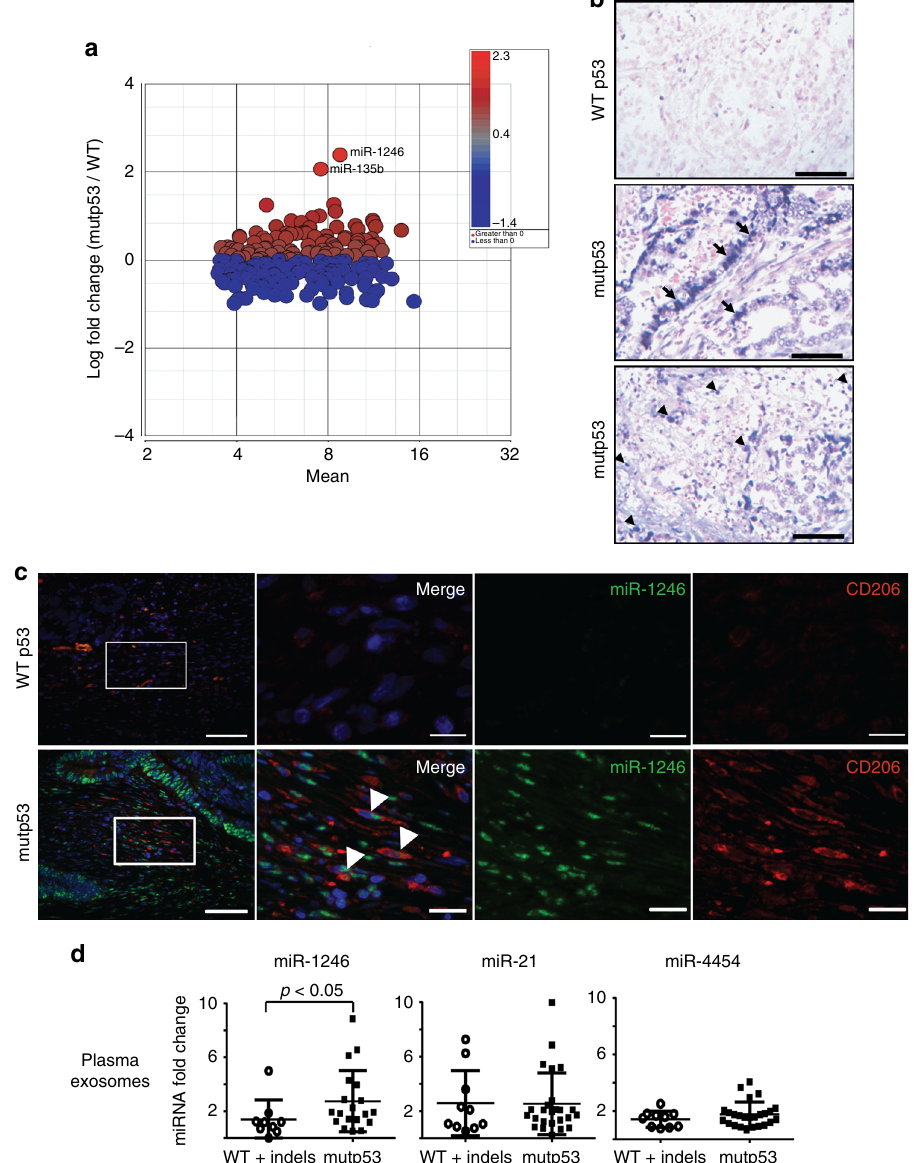
Fig. 6 Mutp53 correlates with miR-1246 in CRC patients. a MicroRNA microarrays were used to pro fi le microRNA expression levels in 27 WT p53 cases and 28 mutp53 cases. Complete table with p values is presented in the Supplementary Information (Supplementary Table 4). b Strong epithelial (middle panel) and stromal (lower panel) miR-1246 hybridization signal in mutp53 tumor compared with WT p53 tumor. Bars = 100 µ m. c Co-detection of miR- 1246 and CD206 in the stroma of sporadic colorectal carcinomas harboring mutp53 and WT p53. White arrowheads demonstrate miR-1246 + /CD206 + cells. Scale bars: 200 μ m (low magni fi cation); 25 μ m (high magni fi cation). DAPI was used for nuclear stain (blue). d Exosomes were isolated from plasma of CRC patients categorized as “ WT + indels ” ( n = 11) or “ mutp53 ” ( n = 25). RNA was extracted from the exosomes and miR-1246, miR-21, and miR-4454 levels were measured using qPCR. Quanti fi cation and normalization were performed using NTA and miR-454. Error bars represent standard